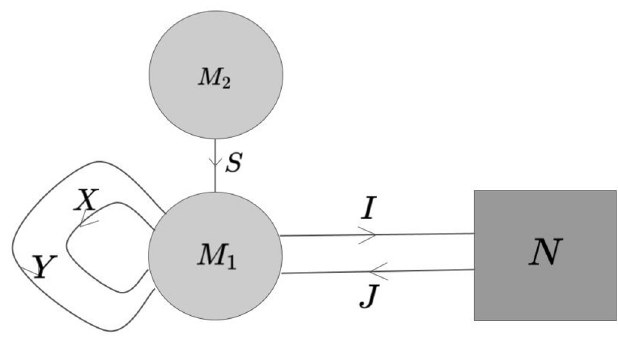
Figure 3 . A subquiver of the whole quiver that is captured by the Witten